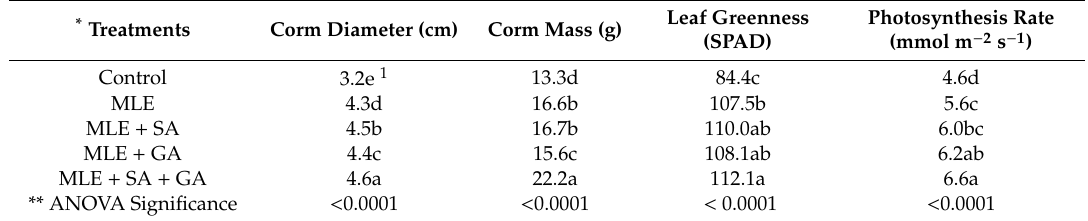
Table 3. E ff ect of soaking corms (24 h) in di ff erent treatment solutions on corm size and plant physiological traits (SPAD, Photosynthesis rate) in gladiolus ( Gladiolus grandiflorus cv. “Nova”).